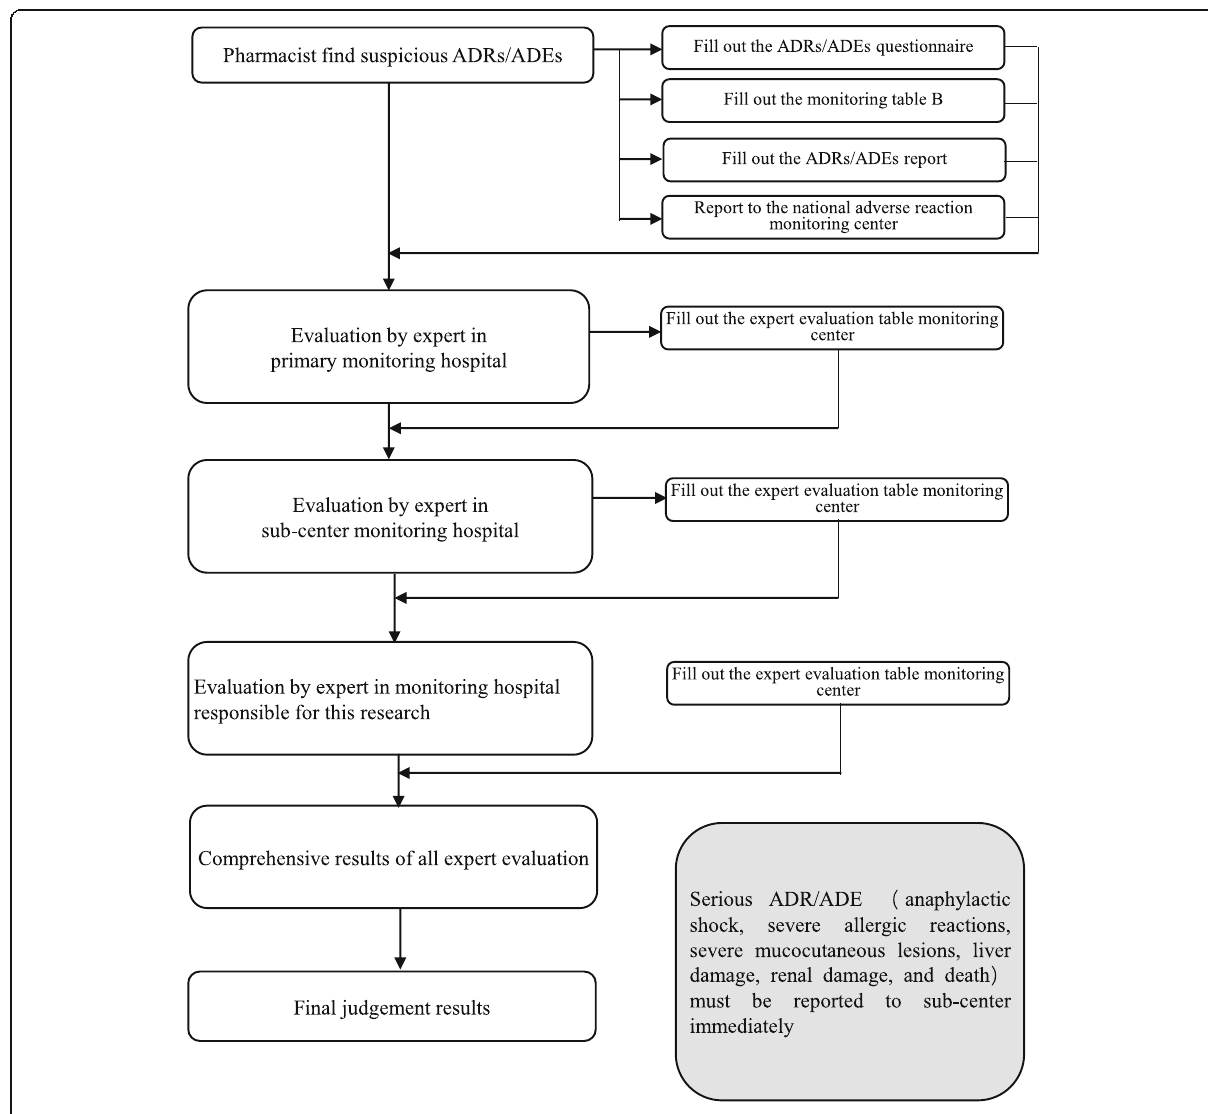
Fig. 2 Treatment flowsheet of